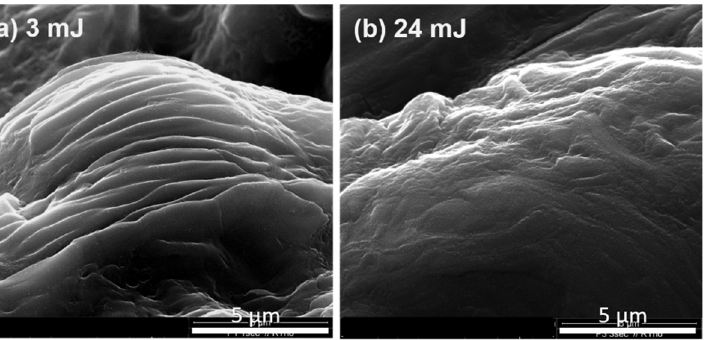
Figure 4. Zone 1. Structure resulting from molten graphite after ablating at two different laser energies. Irradiation time: 1 s/15 pulses.